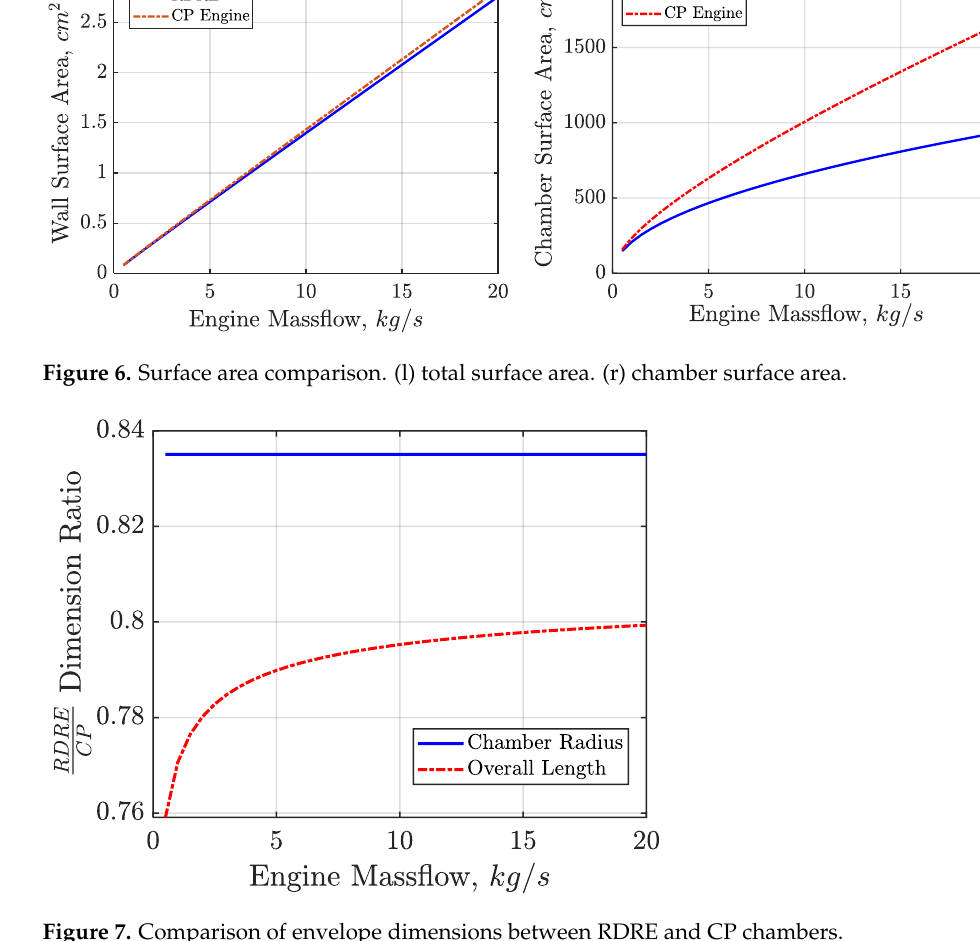
Table 2. Summary of baseline inputs for wall surface area computation.